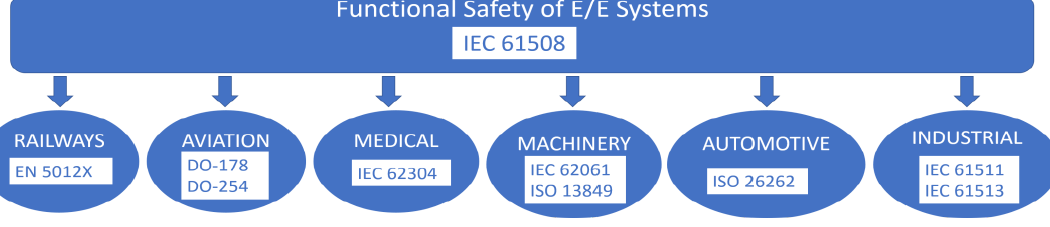
Figure 1. Safety international standards.